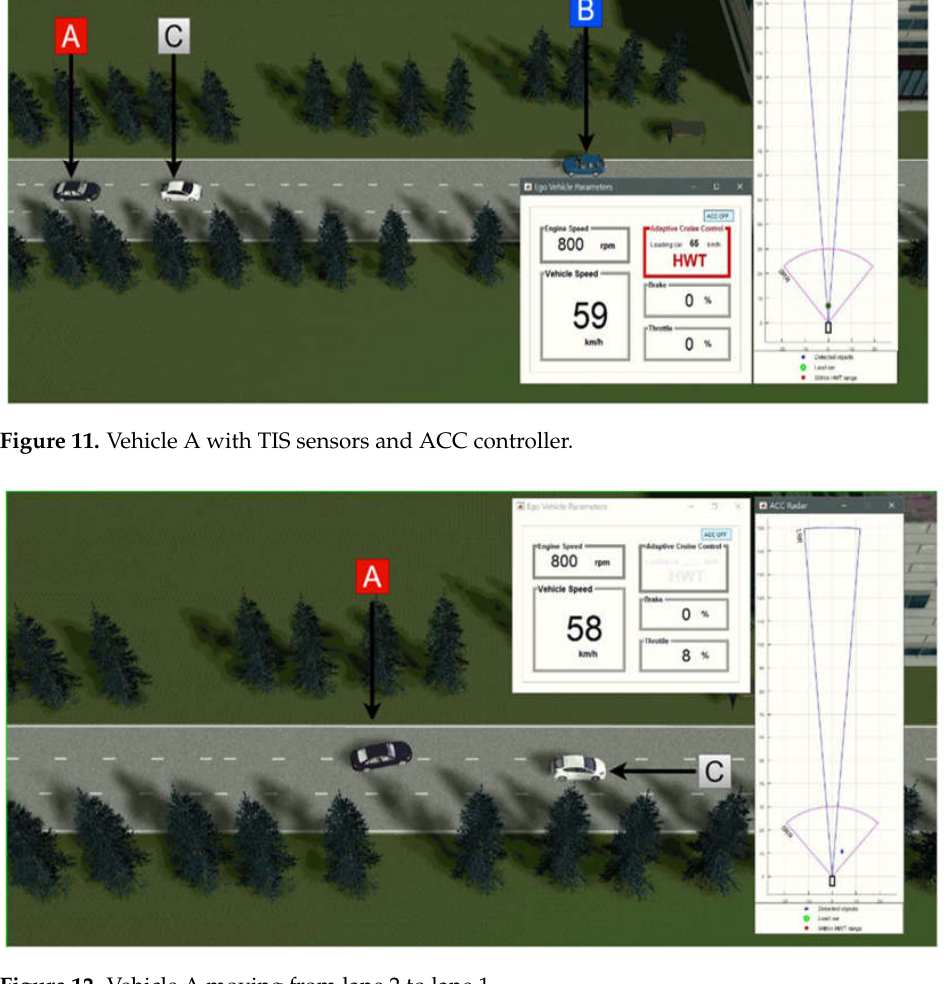
Figure 12. Vehicle A moving from lane 2 to lane 1.